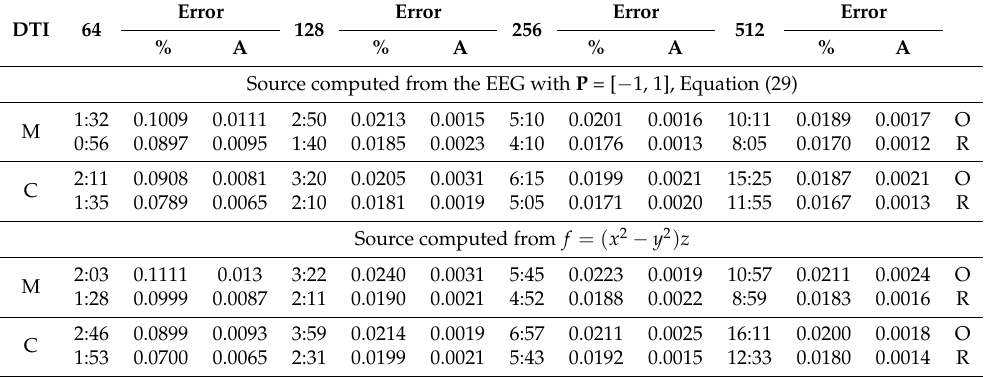
Source computed from the EEG with P = [ − 1, 1], Equation